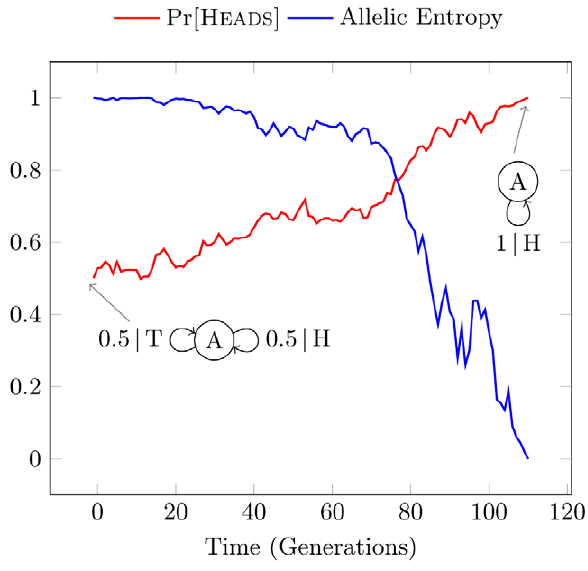
Figure 6. Drift of allelic entropy h m and Pr[H EADS ] for a single realization of the Biased Coin Process with sample size N ~ 100 . The drift of Pr[H EADS ] is annotated with its initial machine M 0 (left inset) and the machine at stasis M 115 (right inset).